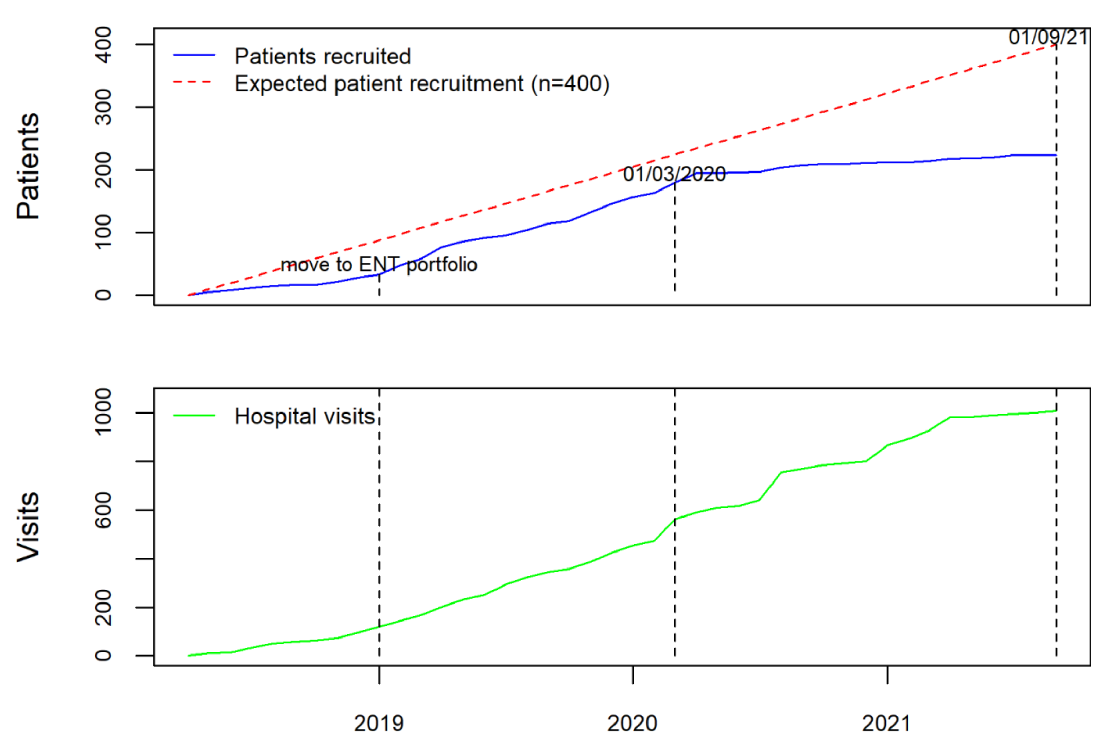
Figure 2. Number of patients and visits added to AIR RRP from 1 st April 2018 until 1 st September